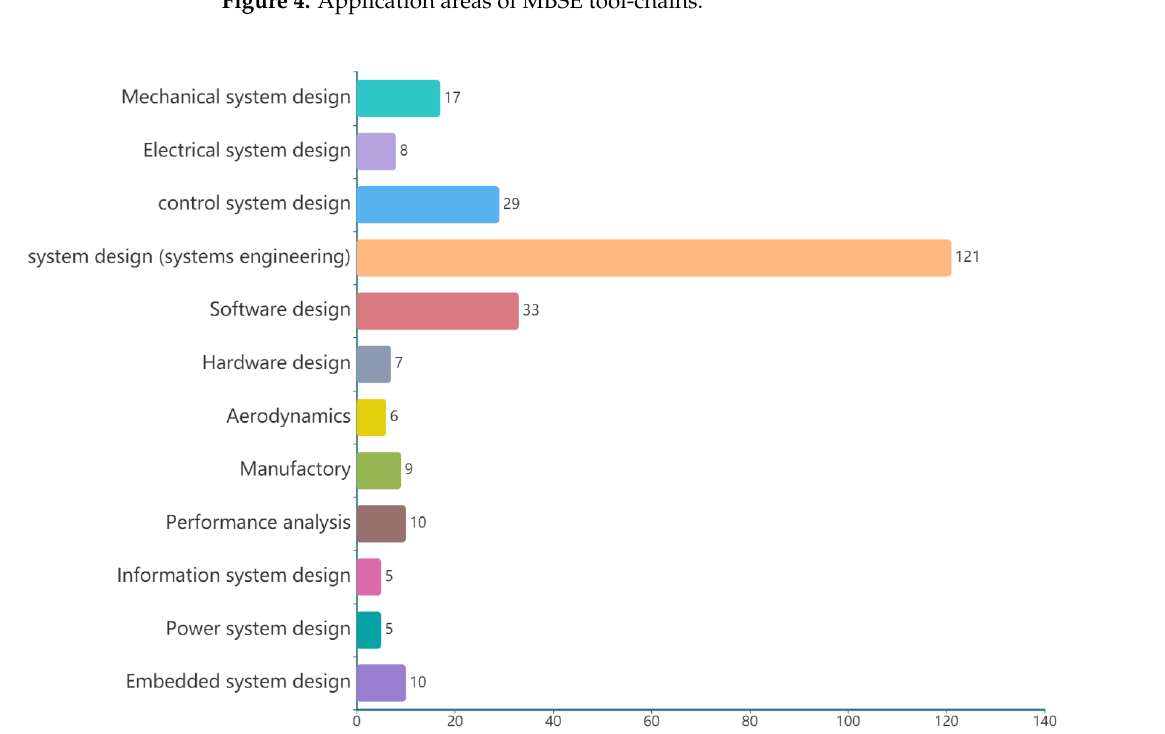
Figure 5. Functionalities of MBSE